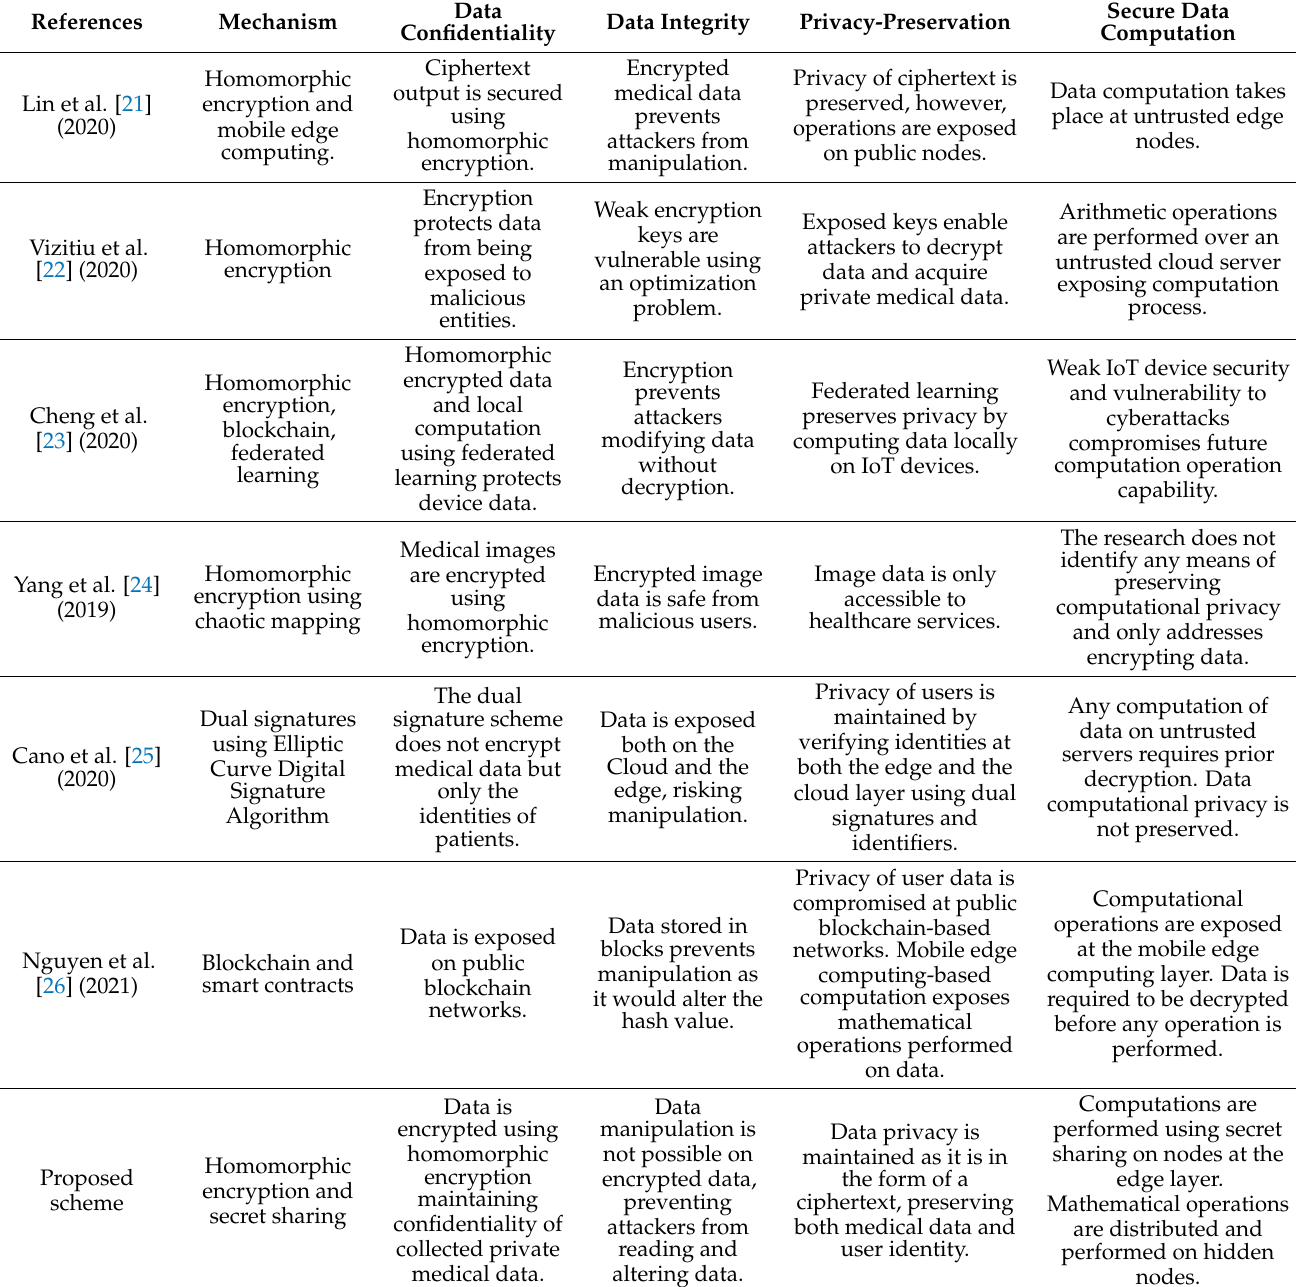
Table 1. Comparative analysis of the proposed scheme with related